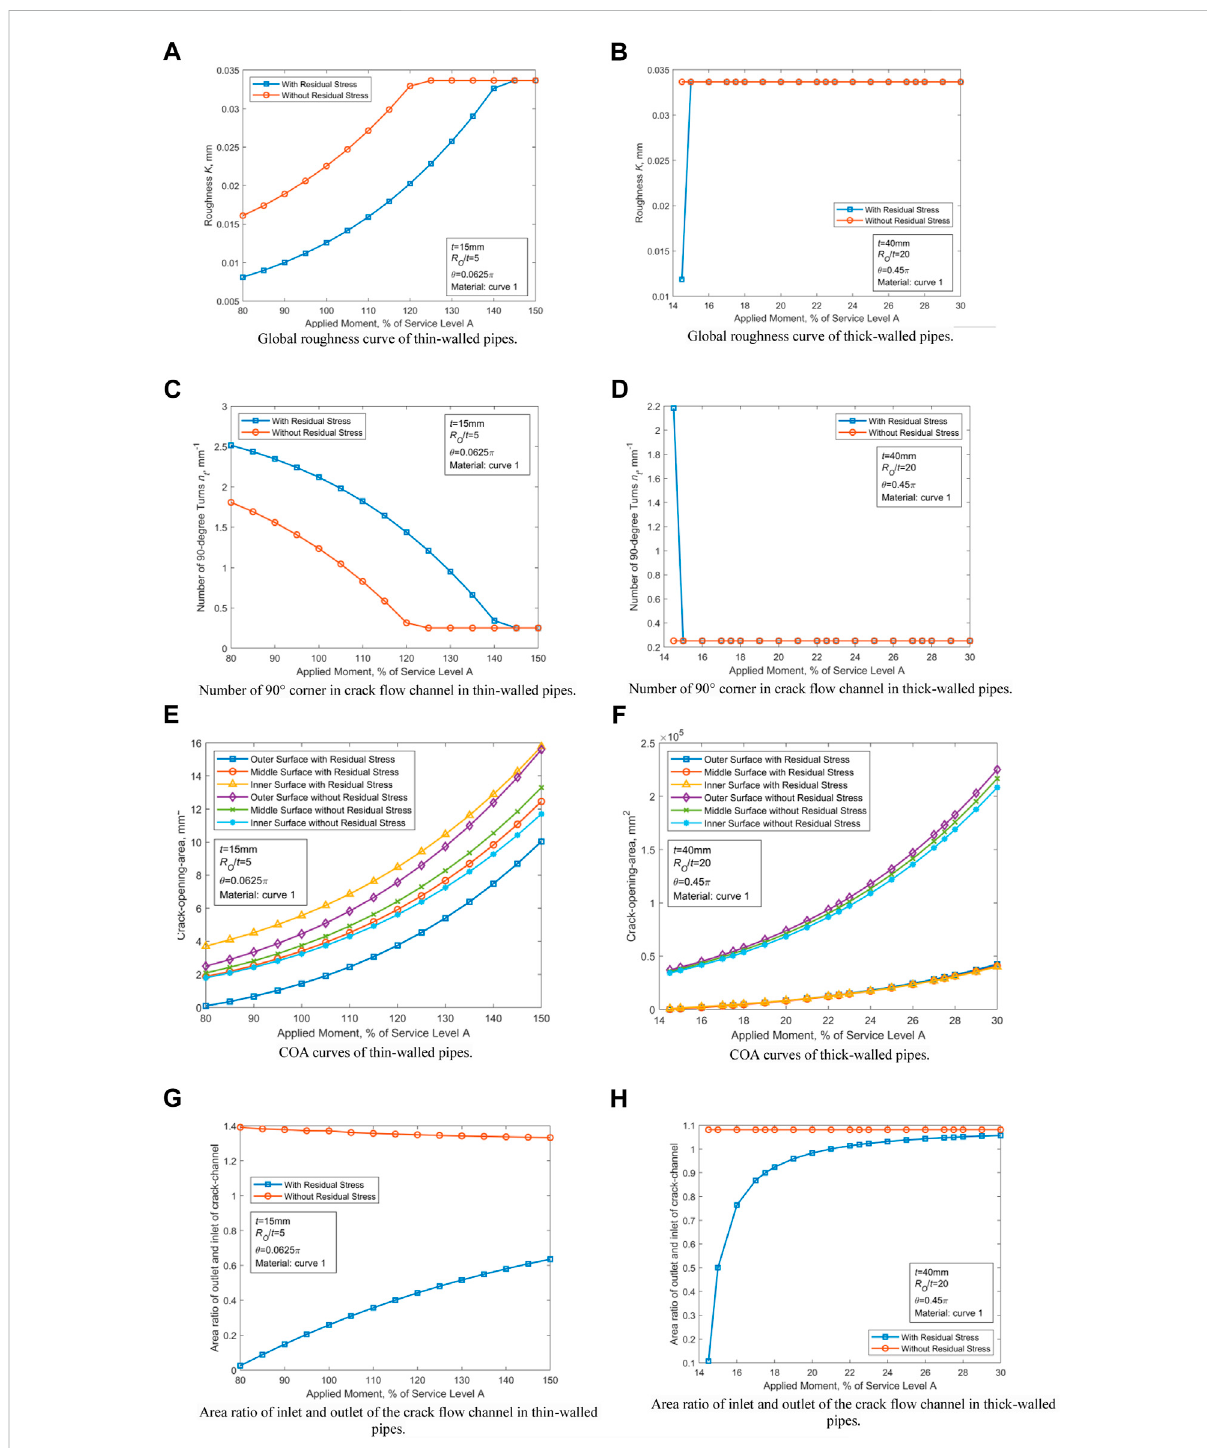
FIGURE 9 Morphology parameters of the crack fl ow channel under WRS ′ action. (A) Global roughness curve of thin-walled pipes. (B) Global roughness curve of thick-walled pipes. (C) Number of 90 ° corner in crack fl ow channel in thin-walled pipes. (D) Number of 90 ° corner in crack fl ow channel in thick-walled pipes. (E) COA curves of thin-walled pipes. (F) COA curves of thick-walled pipes. (G) Area ratio of inlet and outlet of the crack fl ow channel in thin-walled pipes. (H) Area ratio of inlet and outlet of the crack fl ow channel in thick-walled